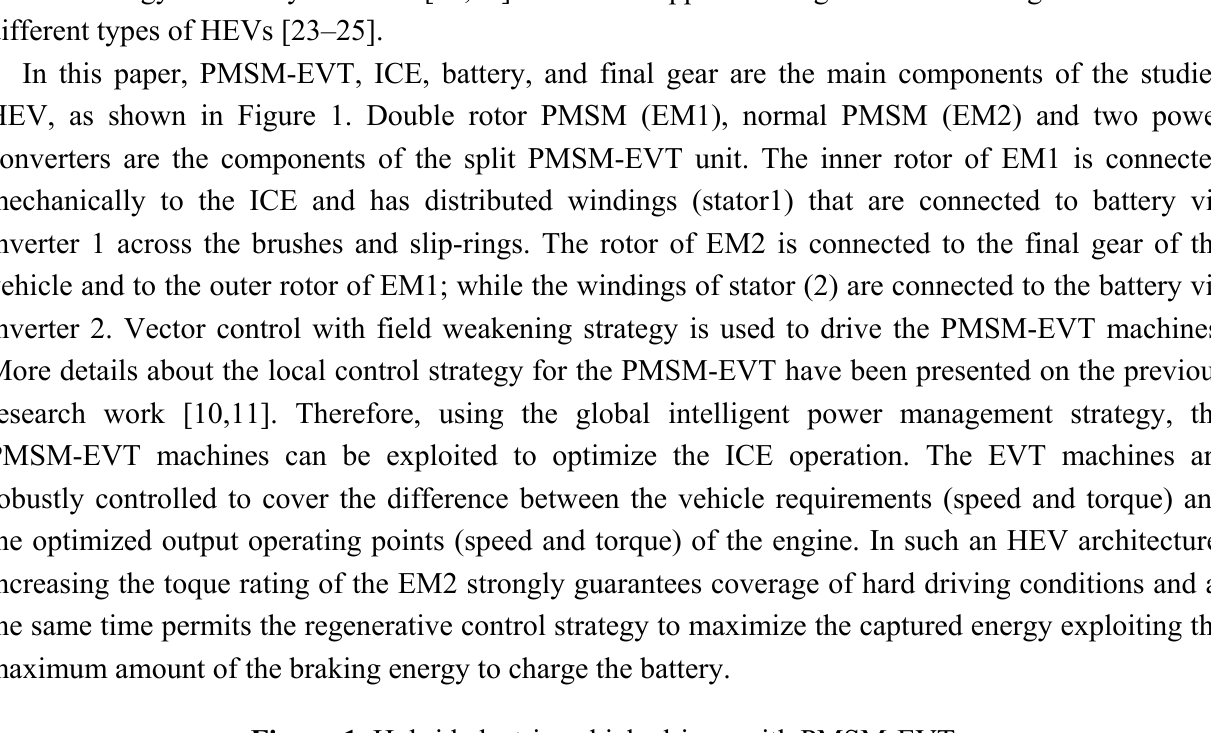
Figure 1. Hybrid electric vehicle driven with